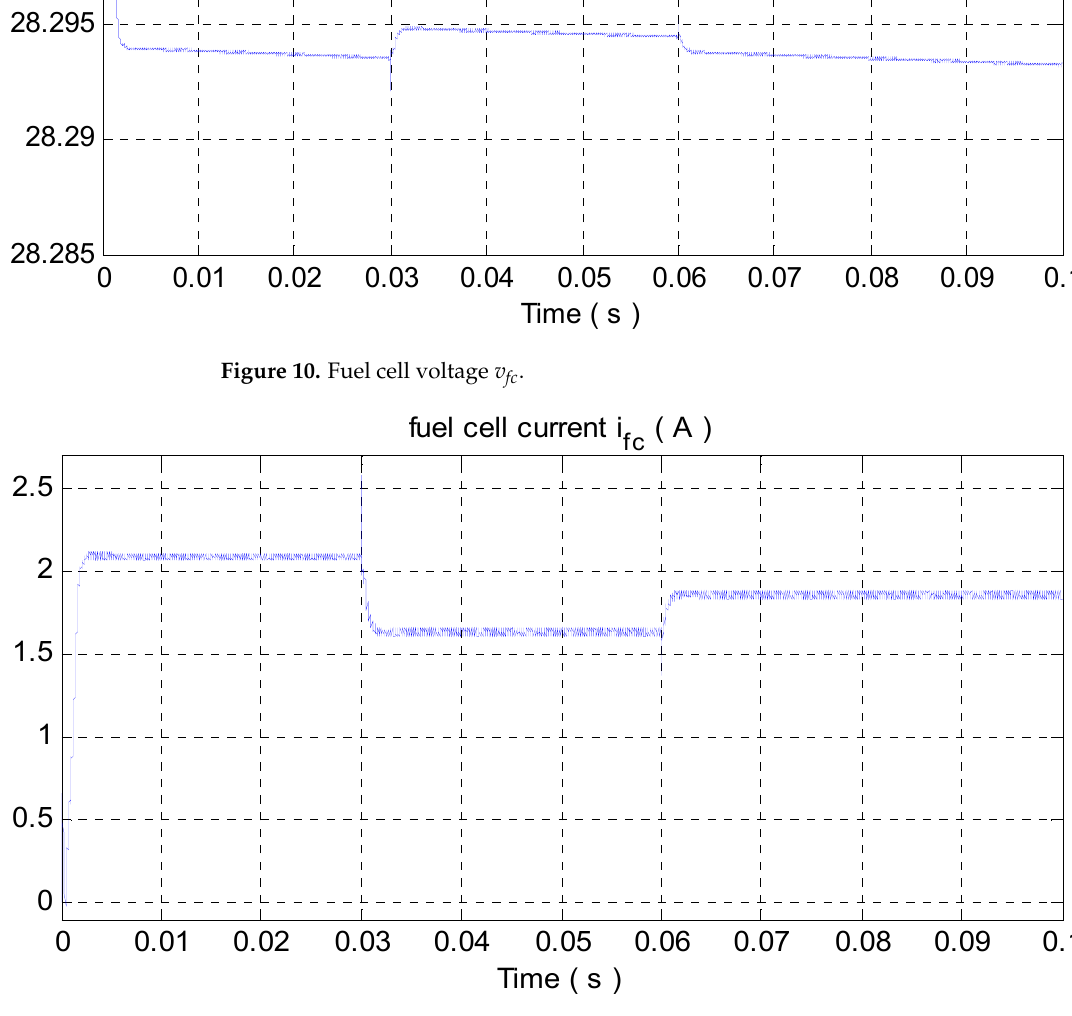
Figure 11. Fuel cell current i fc .